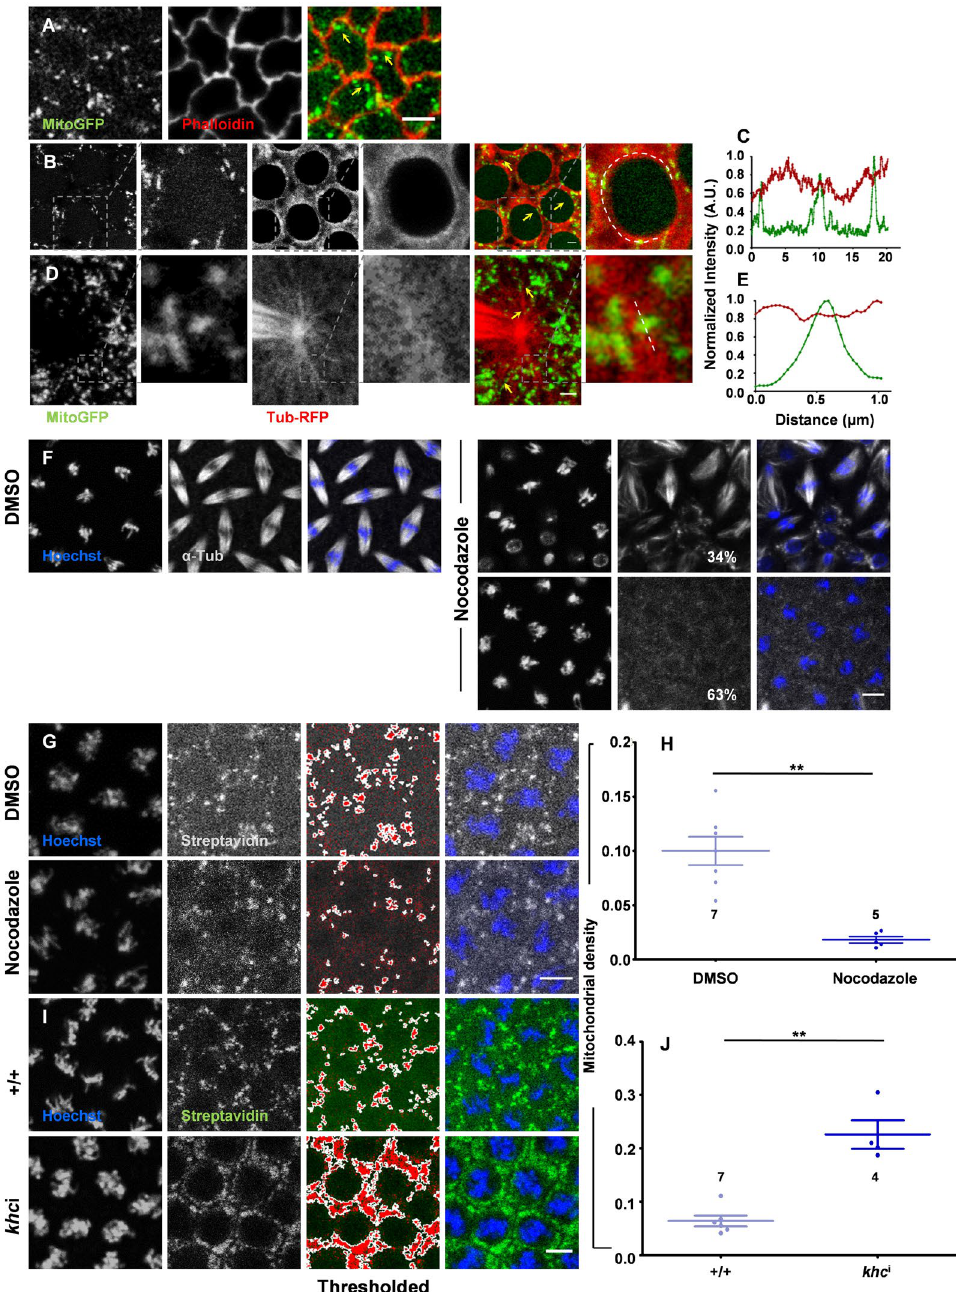
Figure 4. Microtubules regulate mitochondrial density in the apical region in the syncytial Drosophila embryo. ( A ) Mitochondria do not colocalize with cortical actin. Mito-GFP (green) and fluorescence tagged Phalloidin (red) do not colocalize. ( B – E ) Mitochondria are present in proximity to microtubules in the syncytial cycles. Mito-GFP (green) shows partial overlap with Tub-RFP (red) ( B , D ). Mitochondria are lined along perinuclear microtubules in prophase ( B , zoomed selection to the right) and as seen in the intensity line profile ( C ) and along astral microtubule filaments ( D , zoomed in images to the right) and intensity profile shown in E. White lines on merged zoomed in images ( B , D ) represent region shown in line profiles ( C , E ). ( F – H ) Nocodazole treatment decreases apical mitochondrial intensity in syncytial cells. Nocodazole treatment leads to partial (34%) or complete (63%) disruption of metaphase spindles (tubulin’ grey) in syncytial embryos compared to DMSO control. Mitochondria (grey) are sparser in Nocodazole treated embryos as compared to control ( G ). The mitochondrial fluorescence is thresholded, marked and the mitochondrial density is quantified ( H ). (n = 7, 4 embryos and 250, 150 syncytial cells are averaged for control, nocodazole treatment respectively, ** P ≤ 0.01, two tailed Mann–Whitney test). ( I – J ) khc i expressing embryos show an increase in mitochondrial density (green) in apicolateral regions of syncytial cells. (n = 7, 4 embryos, each data point is obtained as an average from 280 and 150 total syncytial cells for control and khc i respectively, ** P ≤ 0.01, two tailed Mann-Whitney test). Scale bar: A, F, G and I: 5 µ m, B, D: 2 µ